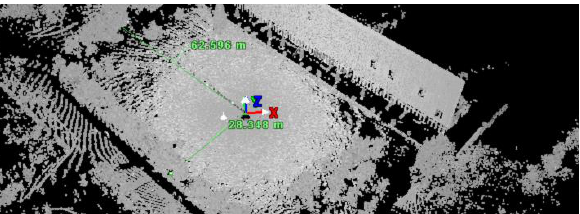
Figure 3: Position of the targets